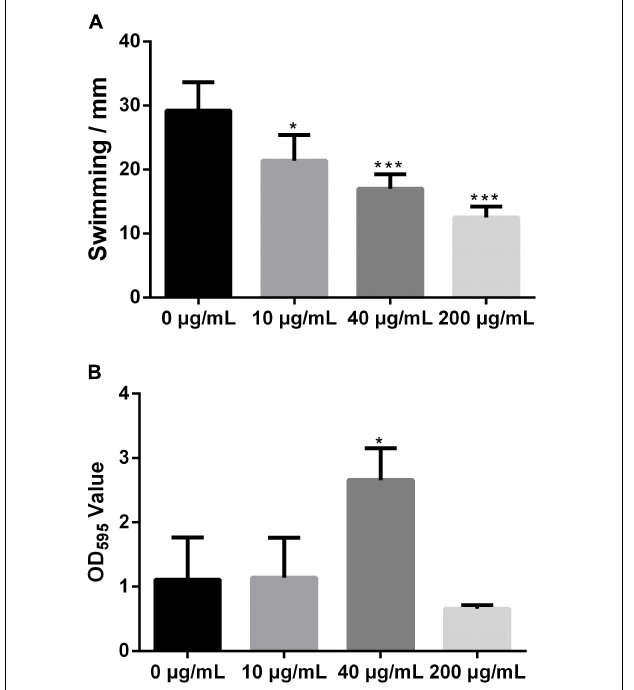
FIGURE 4 | qRT-PCR analysis of the mRNA expression of cell-division-related genes in Xoo treated with melatonin. ∗∗∗ P < 0.001.